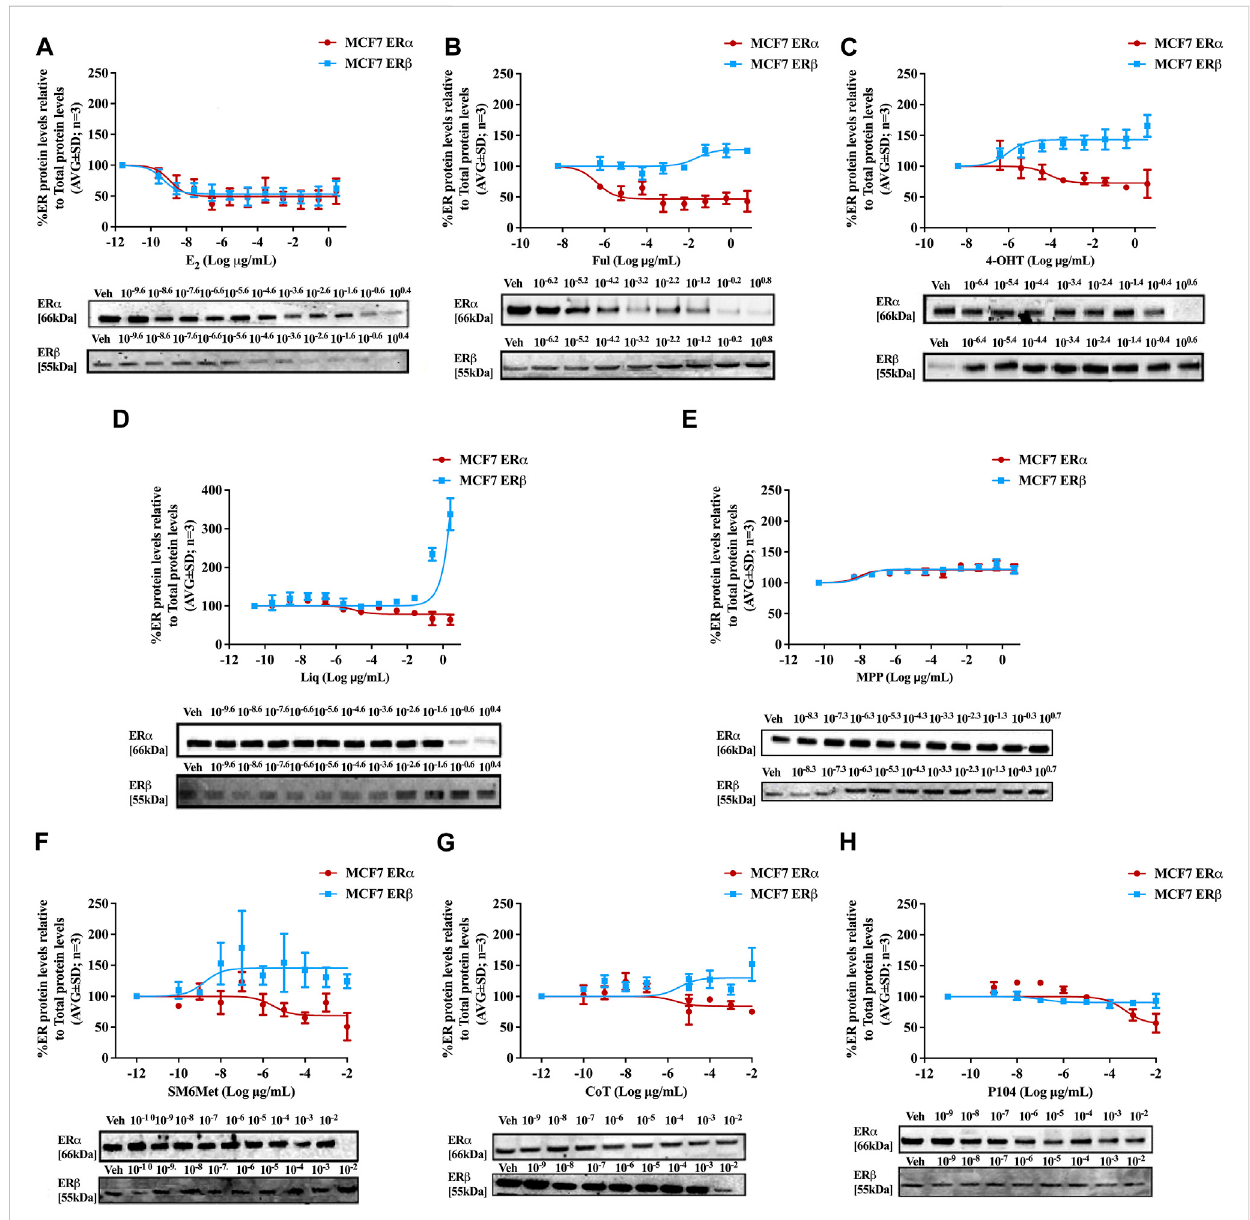
FIGURE 2 EffectoftestpanelonER α andER β proteinlevelsinMCF7cells.MCF7cellsweresteroidstarvedfor24 handthentreatedwitheithervehicle(DMSO) or increasing concentrations of (A) E2, the SOCs, (B) fulvestrant (Ful) or (C) hydroxytamoxifen (4-OHT), or the ER subtype selective ligands, (D) liquiritigenin(Liq)or (E) methyl-piperidino-pyrazole(MPP),ortheCyclopiaextracts, (F) SM6Met, (G) cupoftea(CoT)or (H) P104foranother24 h.TheER α and ER β protein levels were determined using Western blot. The western blots shown as inserts are representative of three independent experiments.Forquanti fi cation,theintensityoftheER α andER β bandsweredeterminedwithMyImageAnalysissoftware,afterwhichtheobtainedvalues were normalized to total protein content and expressed as a percentage (AVG ± SD) of DMSO, which was set at